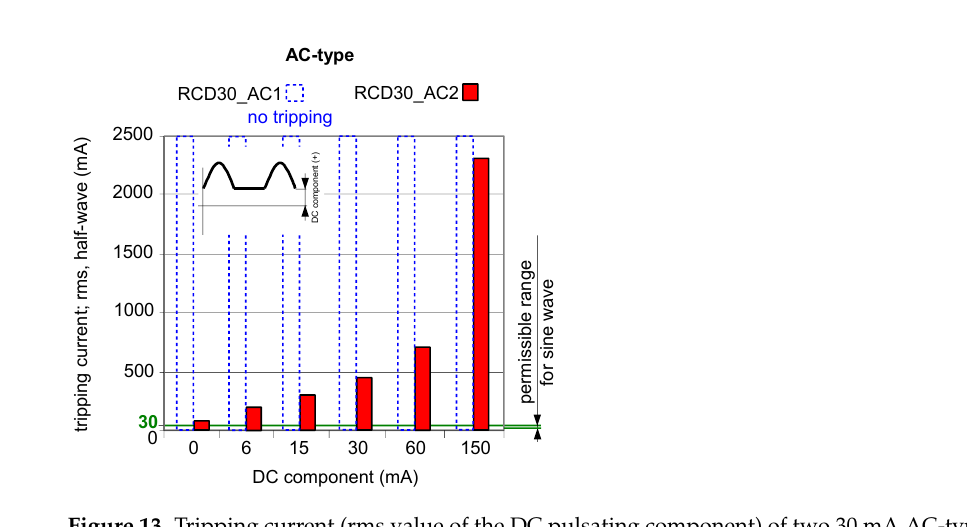
Figure 12. Tripping current (rms value of the AC sinusoidal component) of two 30 mA AC-type RCDs under AC sinusoidal current superimposed by smooth DC component of values 6, 15, 30, 60, and 150 mA.